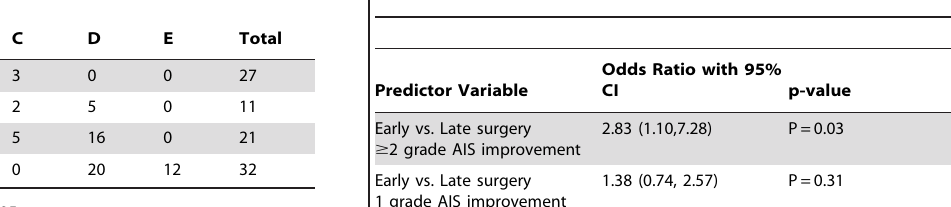
Table 6. Results of generalized ordinal logistic regression model assessing the effect of early vs. late surgical decompression, adjusted for preoperative neurological status and steroid